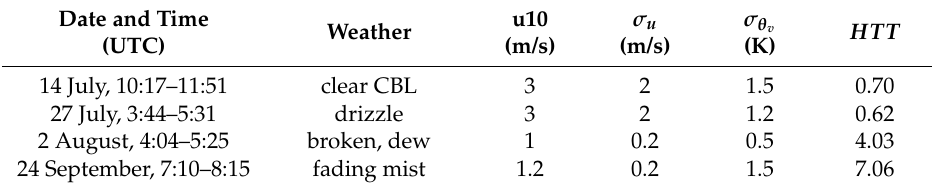
Table 3. Selected characteristics of the experimental cases. u10 is the wind speed at a height of 10 m above the surface, the standard deviations are computed with values of the 5 sites at 2 m above the surface, and HTT stands for ’Heterogeneity Thermal and Topographical